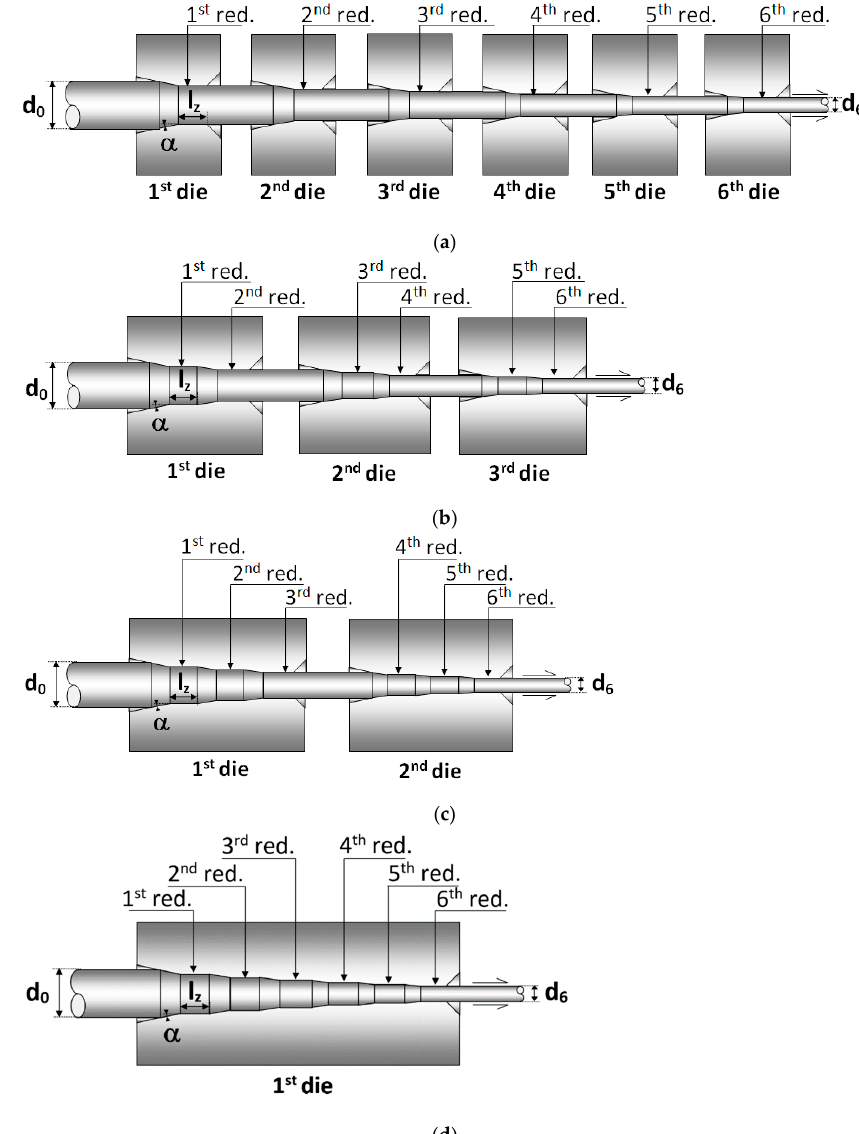
Figure 1. Scheme of simulated wire drawing processes: ( a ) one reduction per die ( conventional drawing ), ( b ) two reductions per die, ( c ) three reductions per die, and ( d ) six reductions per die. In numerical simulations, an elastoplastic solid was selected as a constitutive model with von Mises yield surface and isotropic strain-hardening according to the material true